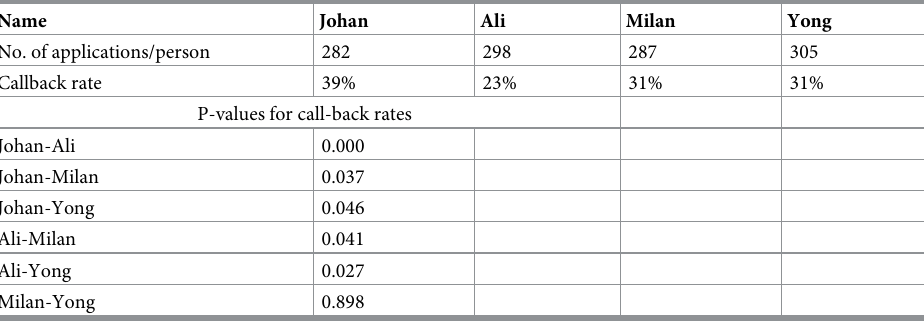
Table 1. Responses per applicant.